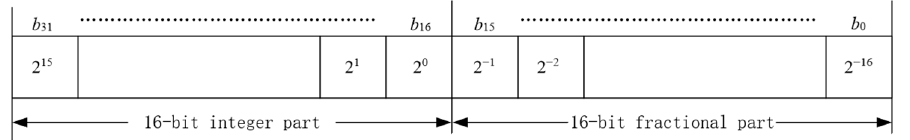
Figure 12. 32-bit fixed-point number format.